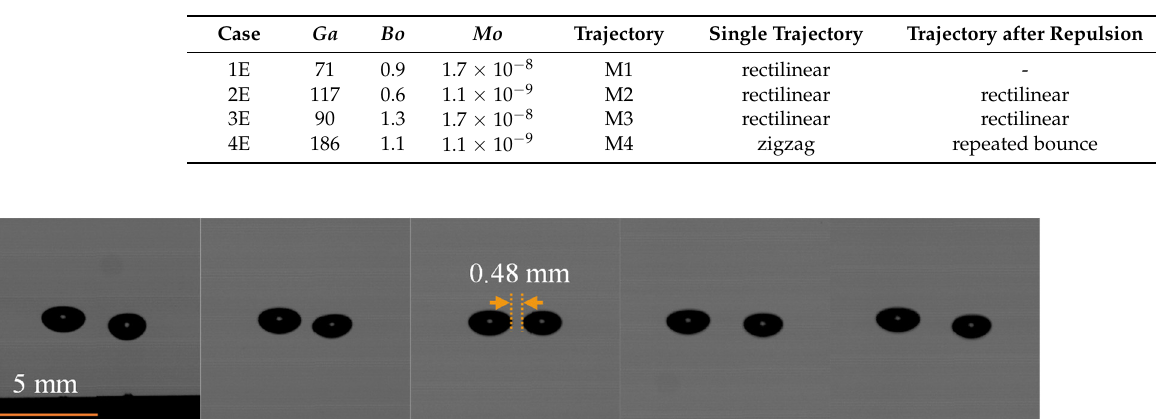
Figure 2. Trajectories of pair of bubbles. Solid line: trajectory of B1; dashed line: trajectory of B2; symbol “o”: location every 50 ms. ( a ) Case 1E; ( b ) case 2E; ( c ) case 3E; ( d ) case 4E. Table 2. Typical trajectories of a pair of bubbles and conditions in experiment.